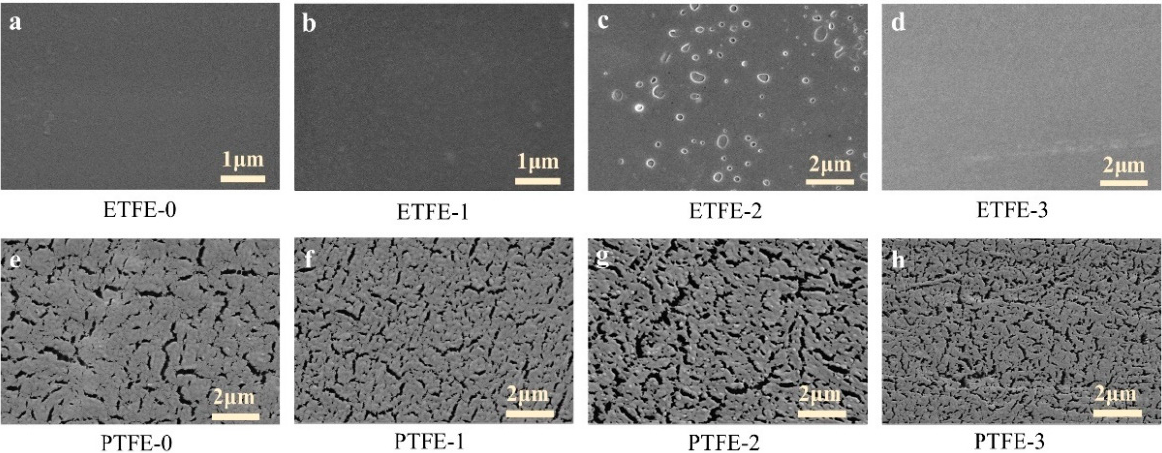
Figure 8. SEM images of membranes surface before and after plasma treatment: ( a – d ) ETFE mem- branes, and ( e – h ) PTFE membranes.